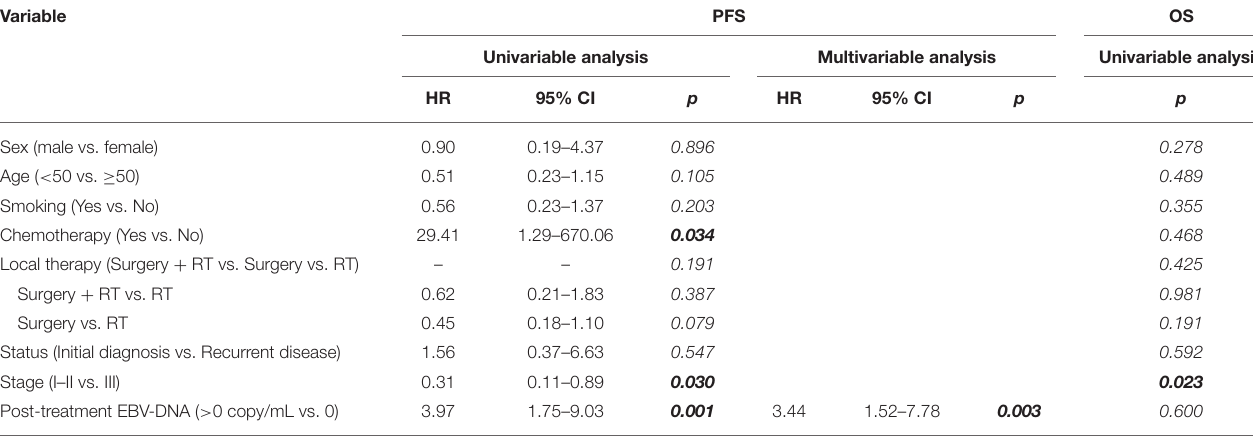
TABLE 3 | Univariable and multivariable Cox regression analyses in the post-treatment set. Variable